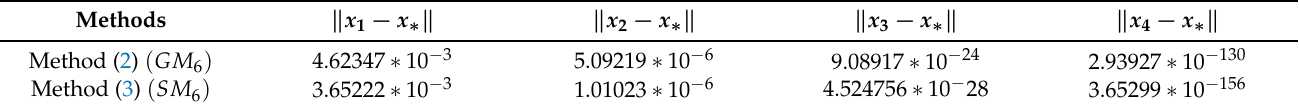
Table 3. Error estimates for Example